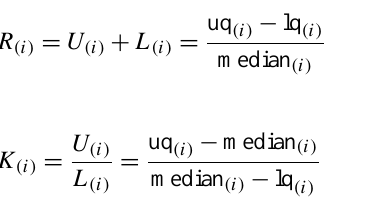
Table 2. The mean value of U , L , R and K of TEC in